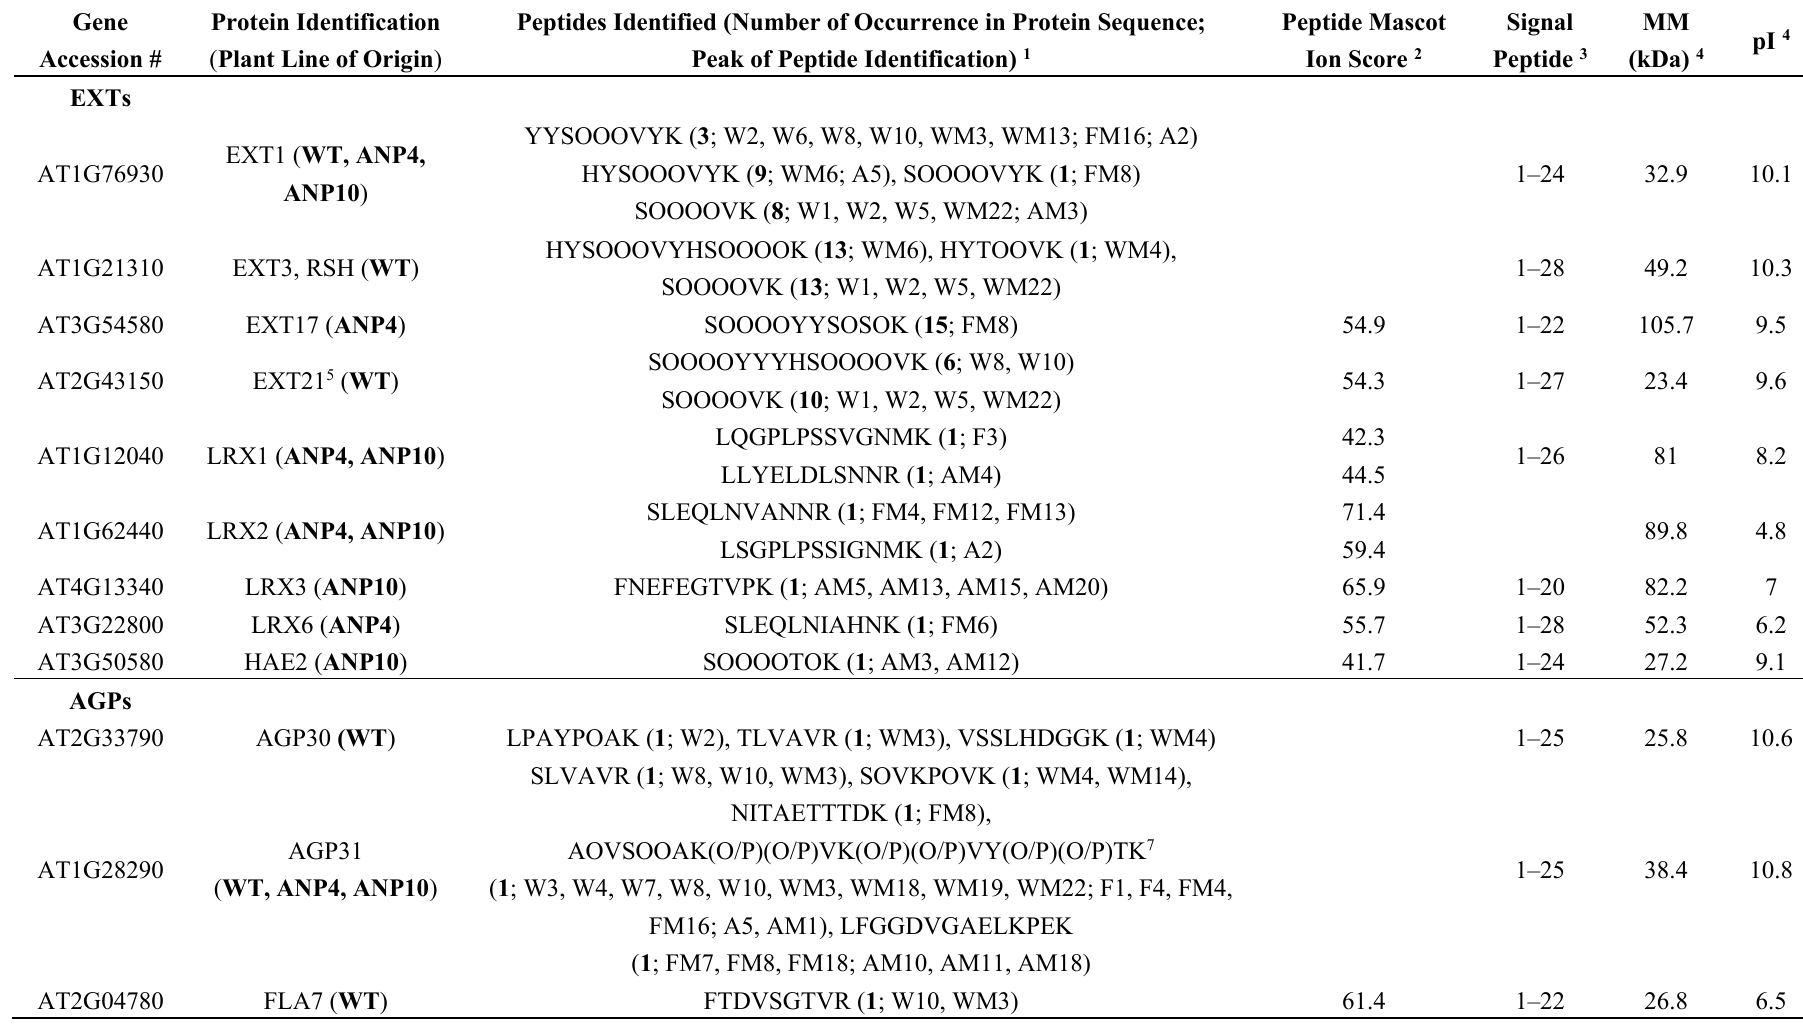
Table 2. HRGPs Identified in WT and ANP Cell Wall